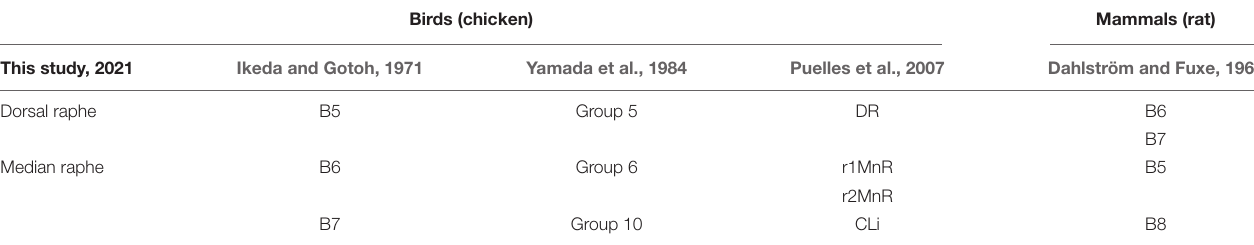
TABLE 1 | Comparison of the terminology regarding the serotonergic neuron cell groups and possible correspondence between birds and mammals.